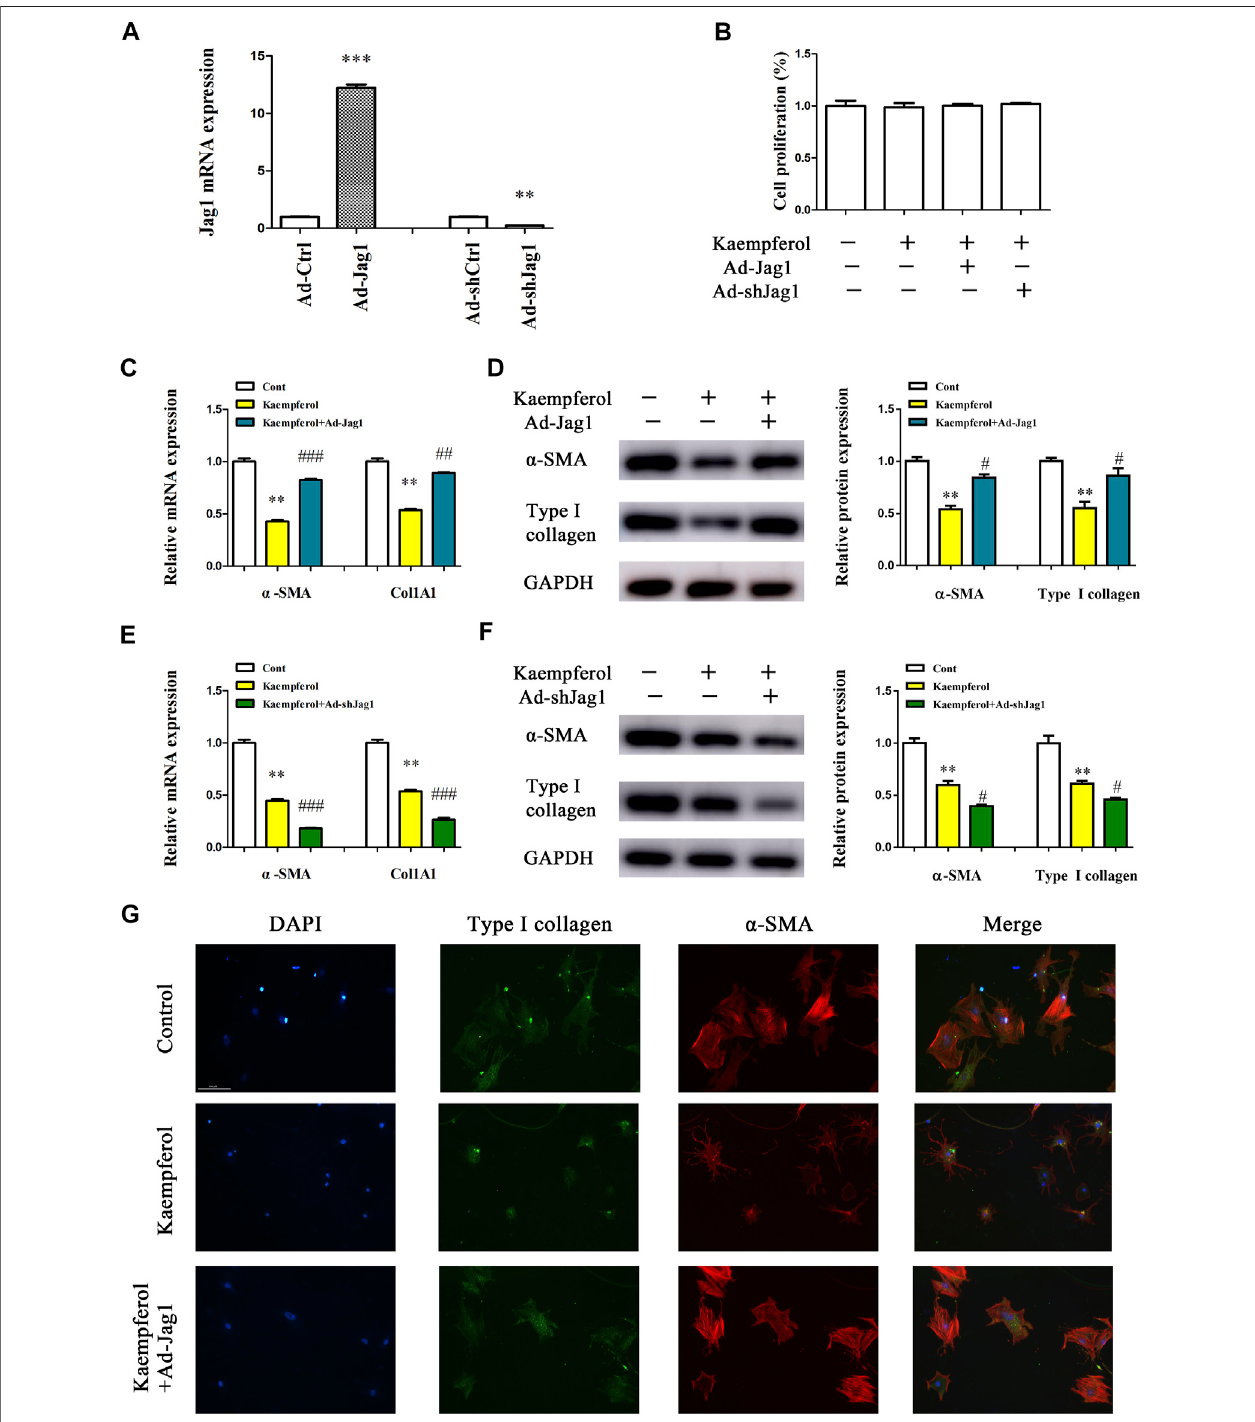
FIGURE 4 | Kaempferol inhibits HSC activation via down-regulating Jag1. Primary 1-day-old HSCs were treated with 10 μ M kaempferol for 24 h and then transducedwithAd-Jag1/Ad-shJag1foradditional24 h (A) Jag1expression. (B) Cellproliferation. mRNA (C) andprotein (D) expressions of α -SMAand Col1A1 incells withJag1overexpression.mRNA (E) andprotein (F) expressionsof α -SMAandCol1A1incellswithJag1knockdown. (G) Immuno fl uorescencestainingfor α -SMA(red) and type I collagen (green). DAPI stained nuclei blue. ** p < 0.01, *** p < 0.01 compared with the control, and # p < 0.05, ## p < 0.01, ### p < 0.001 compared with kaempferol